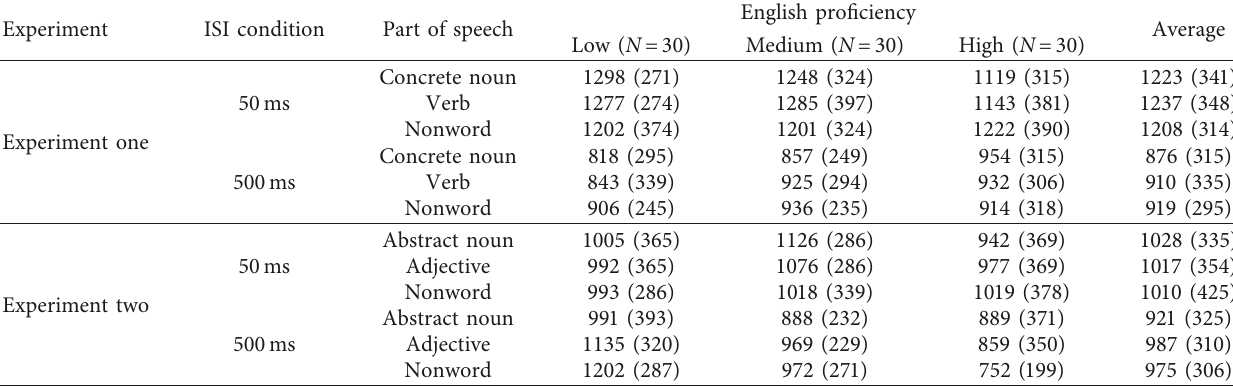
Table 1: Reaction time of part of speech prime effect and consistency rate in the condition of 50ms and 500ms.